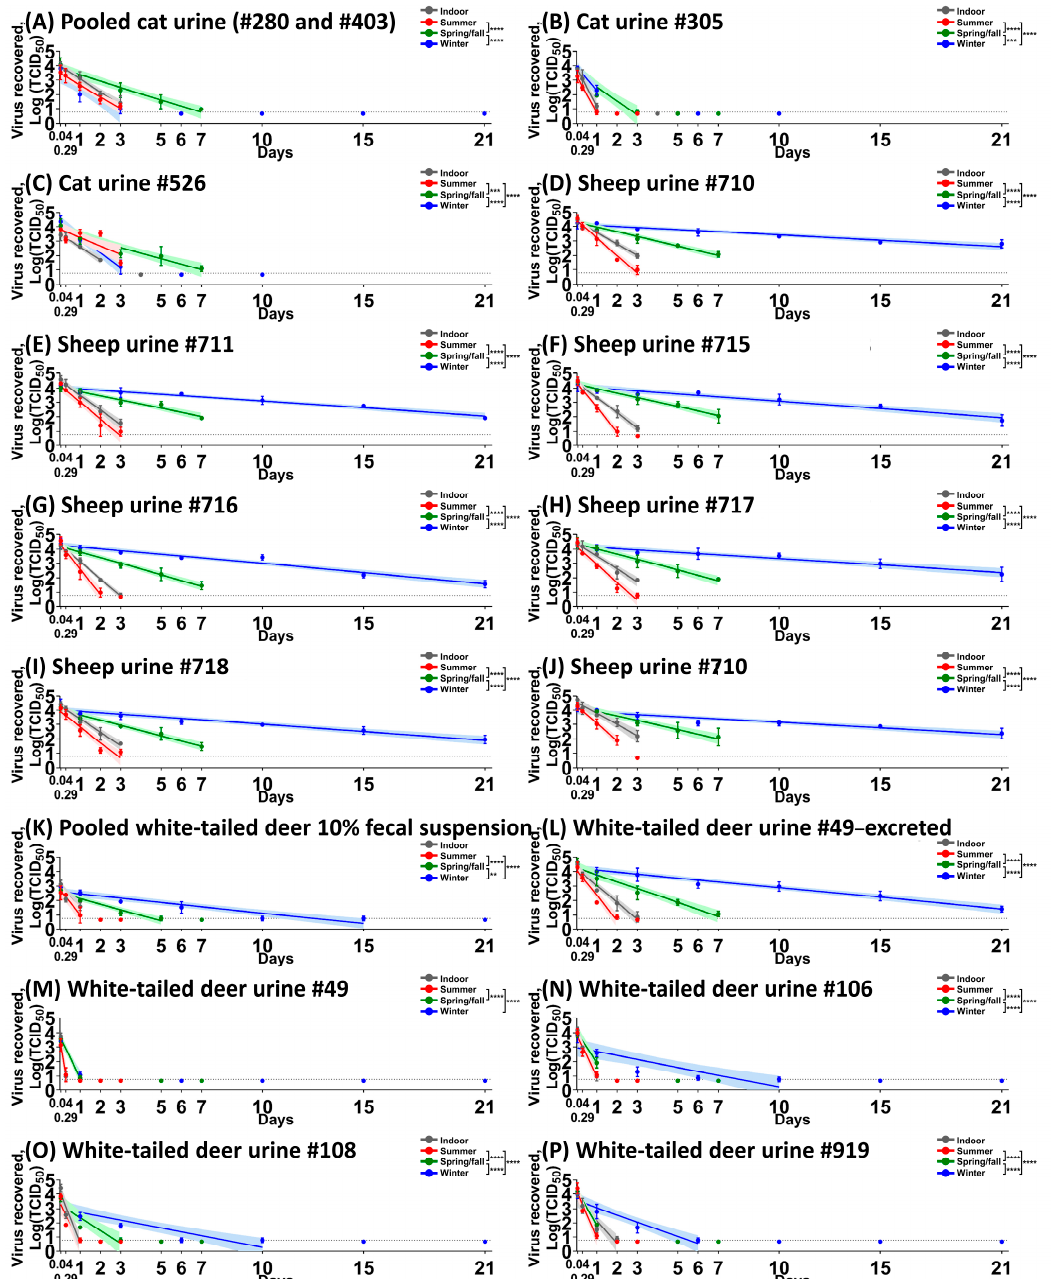
Figure 2. SARS-CoV-2 stability in cat urine ( A ‒ C ), sheep urine ( D ‒ J ), white-tailed deer 10% fecal suspension ( K ), and white-tailed deer urine ( L ‒ P ). Each biological fluid was spiked with 5 × 10 4 TCID 50 of SARS-CoV-2 and incubated under indoor (gray), summer (red), spring/fall (green), and winter (blue) conditions. At each time point, virus was recovered and titrated on Vero E6 cells. The simple linear regression was estimated to calculate the half-life value and compare the values between three climate conditions using ANOVA and subsequent post hoc Tukey’s test. The virus titer is represented as the mean and standard deviation of log-transformed TCID 50 titers (colored circles); colored lines and their shaded areas represent a best-fit line and 95% confidence interval of the simple linear regression. Adjusted p -values for significance are marked: ** ( p < 0.01), *** ( p < 0.001), and **** ( p < 0.0001). On the x-axis, 0.04 and 0.29 days are equal to 1 and 7 h, respectively. Time points were 1 and 7 h, and 1, 2, and 4 days for cat urine #305 and cat urine #526 under indoor